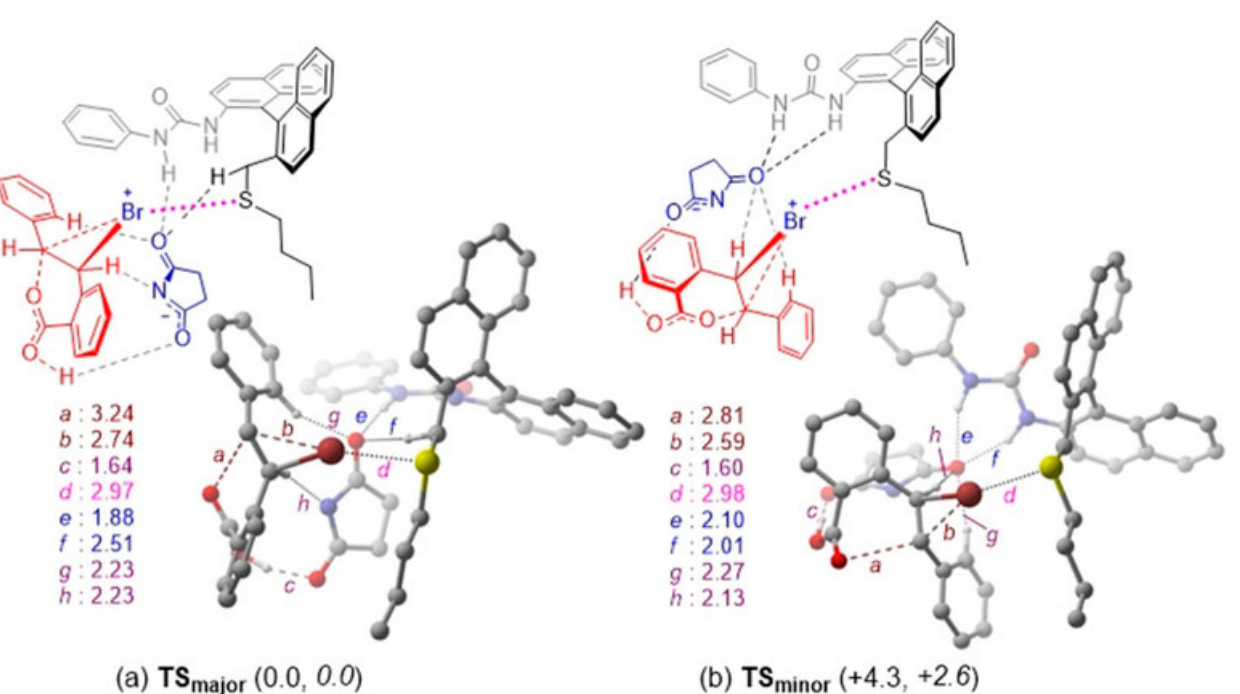
Figure 56. Asymmetric bromolactonization of alkenes 107 catalyzed by a urea-sulfide bifunctional catalyst. 3D structures and the relative Gibbs free energies (kcal mol − 1 ) of TS major ( a ) and TS minor ( b ). Bond lengths are in Å. Reprinted and adapted from Chemistry—A European Journal with permission from Wiley [106].